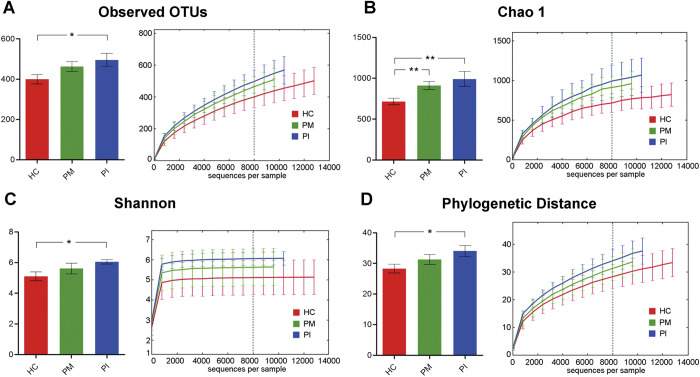
Calculation of alpha diversity values for comparison of the total microbial diversity of healthy implant (HC), peri-implant mucositis (PM), and peri-implantitis (PI) sites.Alpha diversity values were calculated based on a subsample of 8000 sequences from each dataset. *P < 0.05, **P < 0.01 by two-tailed t-test. (A) The numbers of observed OTUs increased in both PM and PI. (B) The estimated OTU numbers (Chao1) of PM and PI were significantly greater than that of HC. (C) Microbial community diversity analysis (Shannon index) showed that the PI microbial community exhibited the greatest diversity. (D) Phylogenetic diversity (PD) measures of community diversity.